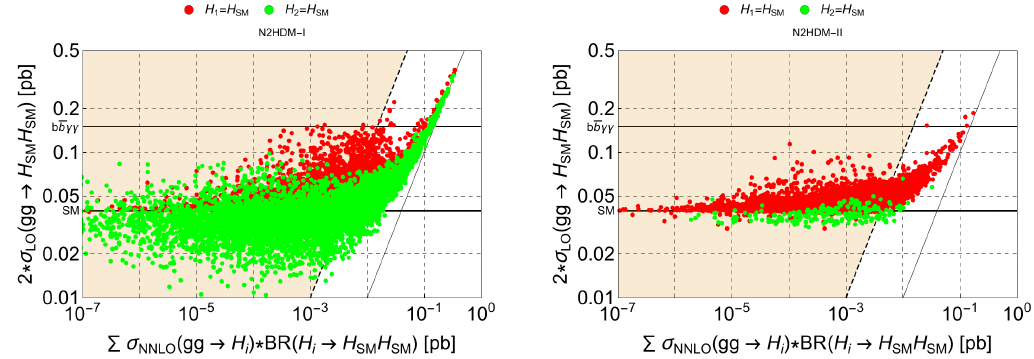
Figure 4 . N2HDM: LO gluon fusion cross sections, multiplied by a factor 2 to approximate the NLO QCD corrections, into a SM-like Higgs pair with H for all points passing our constraints, as a function of the NNLO cross section for resonant heavy Higgs H production with subsequent decay into a SM-like Higgs pair. For H i we sum up the single Higgs production cross sections of H The horizontal line denoted by SM corresponds to the SM Higgs pair production value, and the one denoted by b ¯ bγγ to the limit from non-resonant di-Higgs searches in the 2 b 2 γ final state. For the shaded region, see